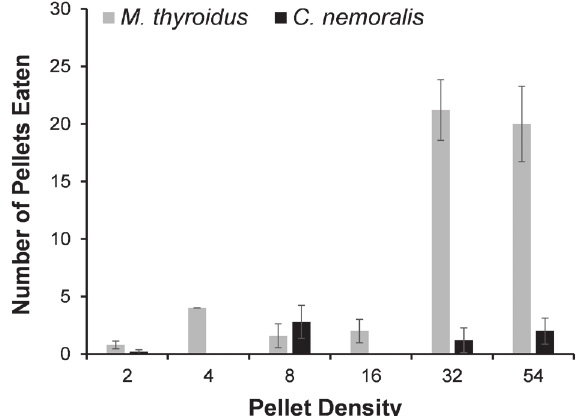
Figure 3. Mean ( ± SE) pellets eaten in joint foraging experiments across increasing food levels by native M. thyroidus (gray) and introduced C. nemoralis (black)